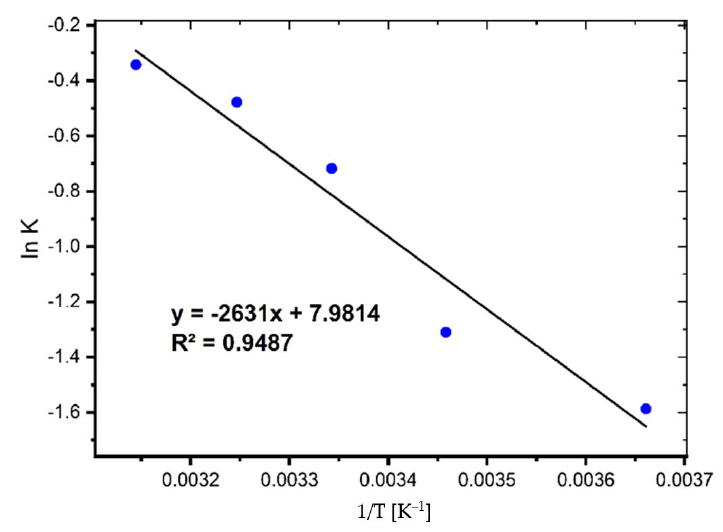
Figure 6. Activation energy plot for the adsorption of MB on coal.